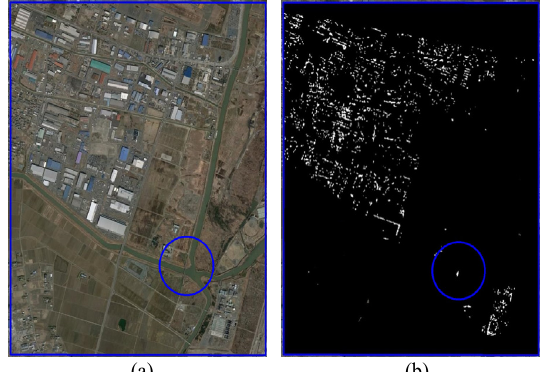
Figure 8. (a) The Google Earth image imposed within the computation area in the study case of detecting broken bridge. in Figure 1. (b) The result of linear-feature change detection using Curvelet-based approach. The blue circle marks the broken bridge which is successfully detected in this study